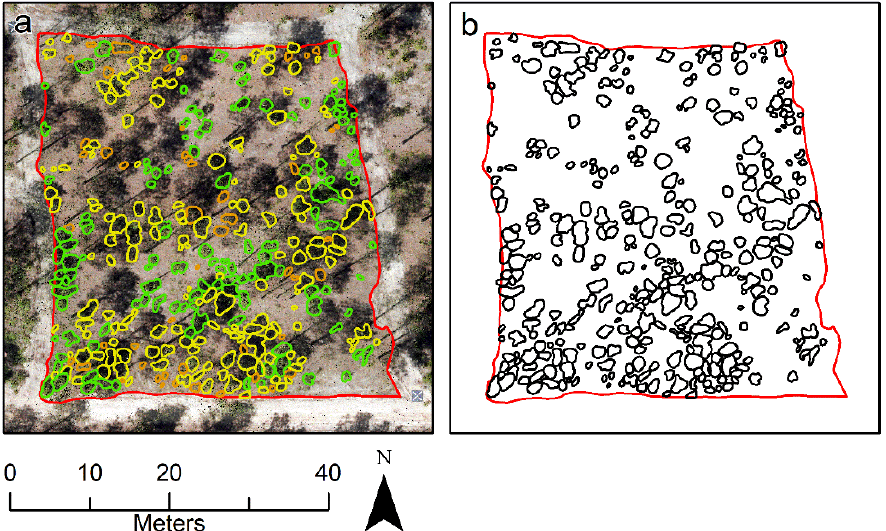
Figure 7. ( a ) Sparkleberry confidence metric expressed in unit 16D1 with color coding (high-confidence = green, medium-confidence = yellow, low-confidence = orange). ( b ) All sparkleberry clump polygons digitized in unit 16D1, depicting the areal coverage and distribution of shrub clumps.